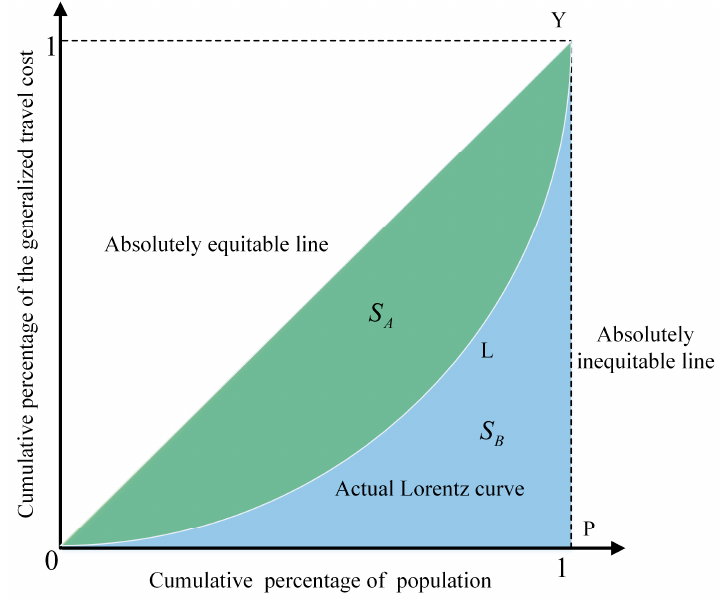
Figure 4. Lorentz curve.